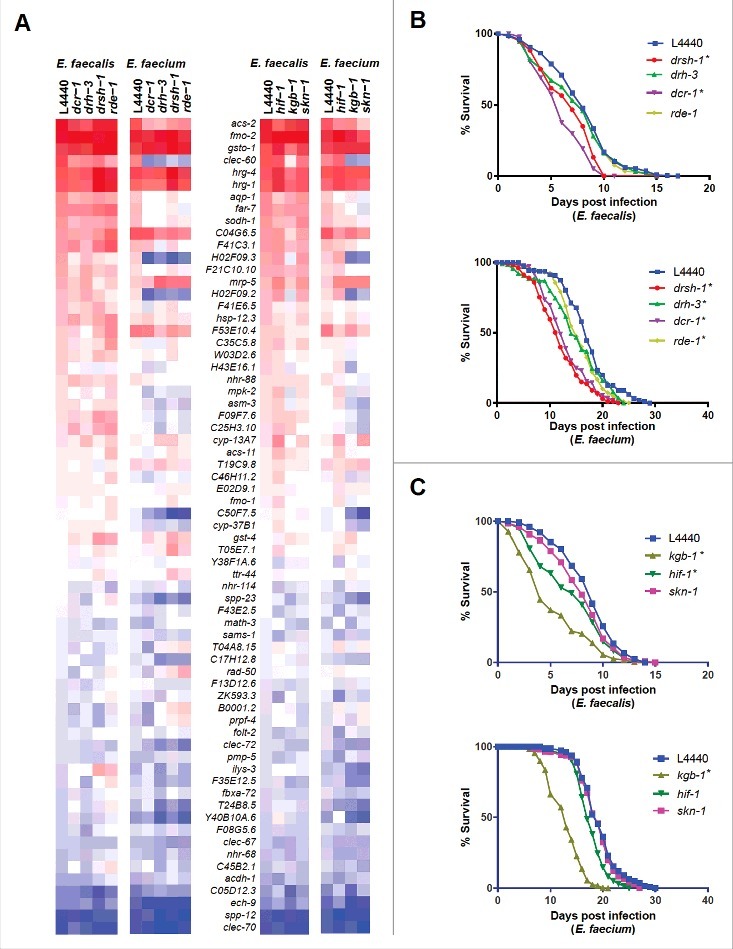
Stress response pathways are required for defense against Enterococcus. (a) Heat-map of the fold-changes of Enterococcus-activated genes in N2 worms treated with RNAi against C. elegans small RNA pathway components (drsh-1, drh-3, dcr-1 or rde-1) (two panels on left) or stress response pathway components (hif-1, kgb-1, or skn-1) (two panels on right) or vector control (L4440) during infection with E. faecalis or E. faecium relative to heat-killed E. coli control. The heat-map reflects data from 2 biological replicates for each mutant analyzed. (b) Effect of Enterococcus infection on the survival of fer-15(b26);fem-1(hc17) C. elegans treated with L4440 vector control, drsh-1, drh-3, dcr-1 or rde-1 RNAi. (c) Effect of Enterococcus infection on the survival of fer-15;fem-1 C. elegans treated with L4440 vector control, kgb-1, hif-1 or skn-1 RNAi strains. For (b) and (c), each graph shows the average of three plates for each strain, with each plate containing 30–40 worms. results are representative of 3 independent assays and statistical significance of differences between survival curves was calculated using Kaplan-Meier log rank analysis. Relevant statistically significant survival curves (relative to control) are marked with asterisks.